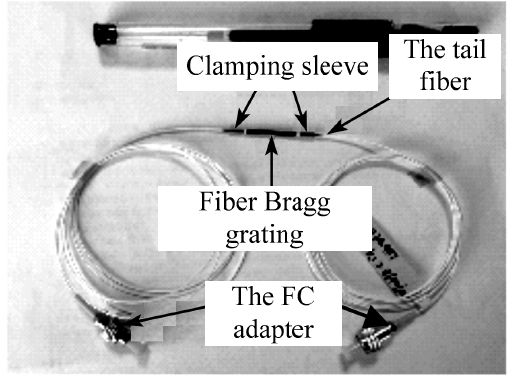
Figure 6. Working principle and structure diagram of sensitized FBG sensor.